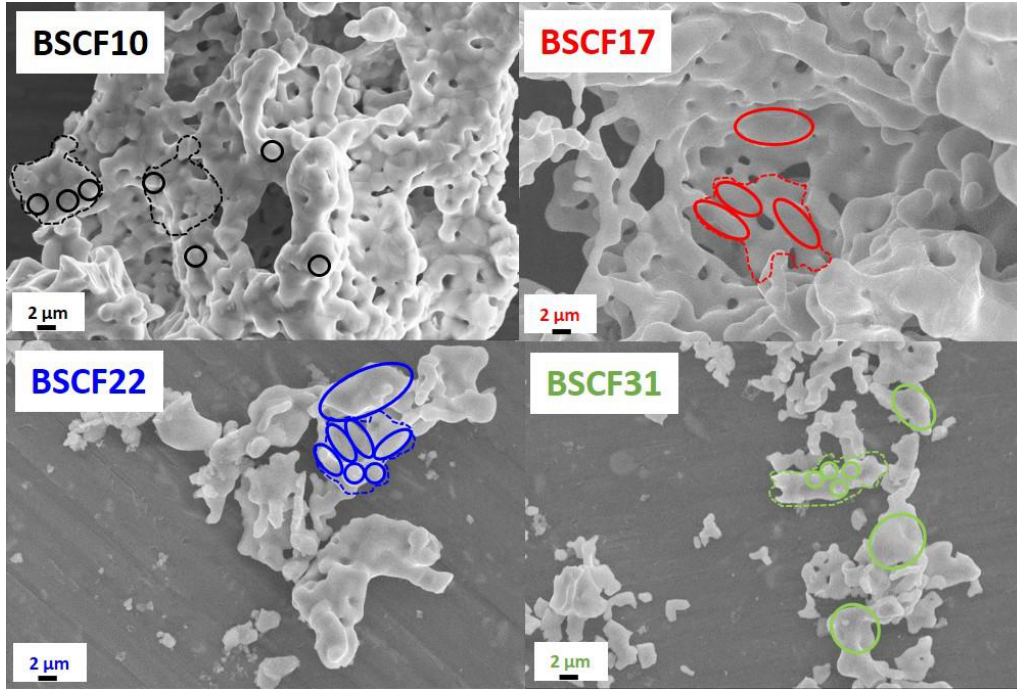
Figure 4. SEM images of the powders after thermal treatment at 950 °C/5h: BSCF10 ( top, left ), BSCF17 ( top, right ), BSCF22 ( bottom, left ) and BSCF31 ( bottom, right ). For each image, the primary particles are evidenced by circles and ovals, whereas agglomerates are indicated by dotted lines with the specific color of each sample.